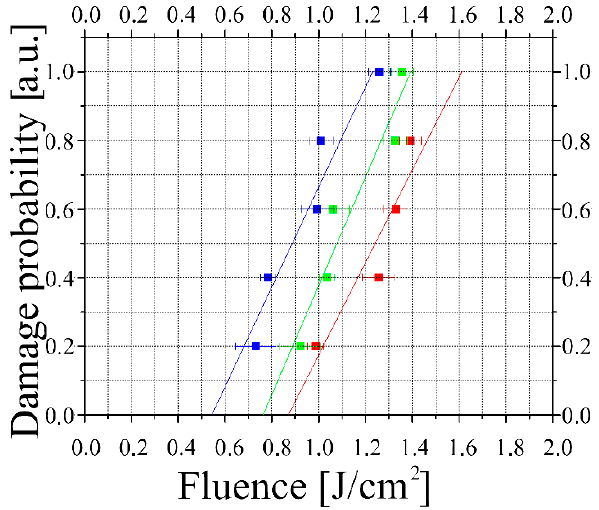
Figure 10. Probability of the optical damage of the N1 sample on the pump fluence at different exposure durations of 1 s (red squares), 10 s (green squares), and 20 s (blue squares). The pulse width, PRR, and the beam diameter were 18 ns, 12 kHz, and 360 µm, respectively.